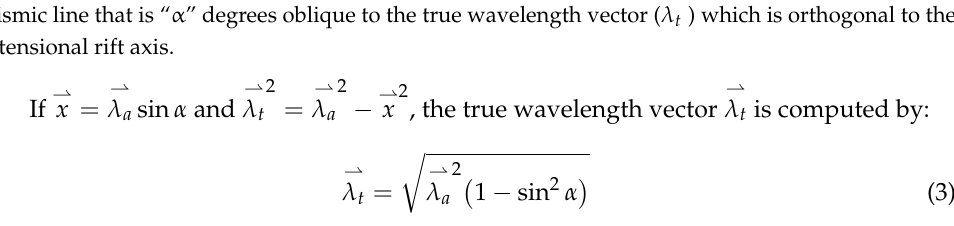
(cid:42) λ a ) observed on a (cid:42) λ t ) which is orthogonal to the